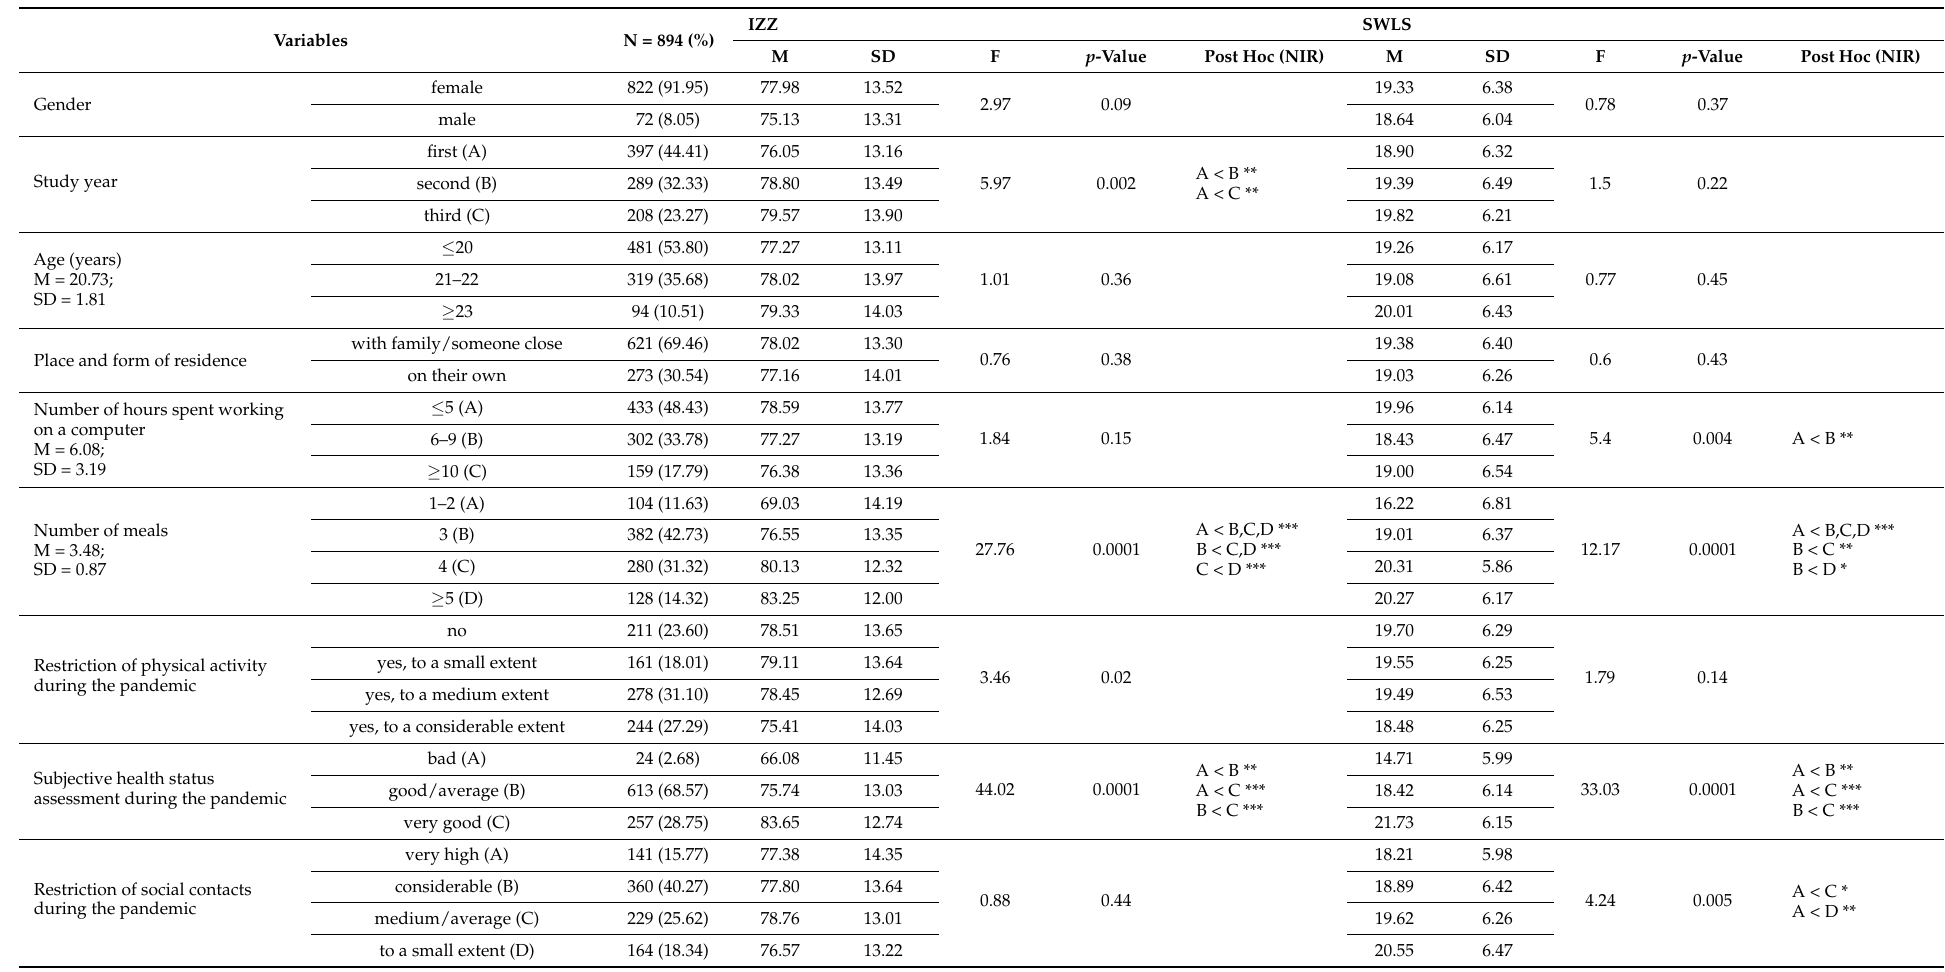
Table 2. The significance of the impact of sociodemographic and lifestyle-related variables on the general intensity of health behaviours and satisfaction with life.